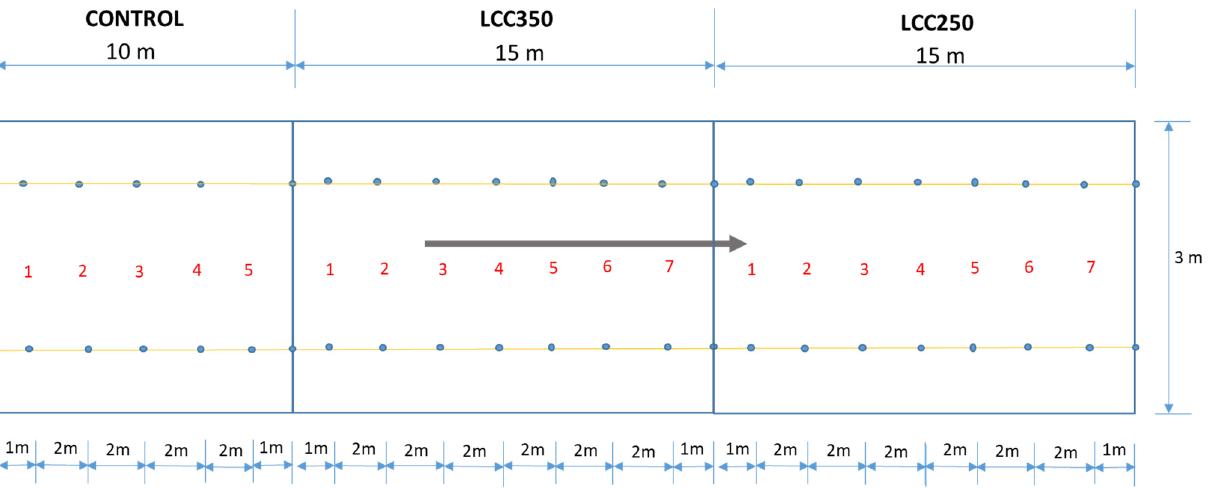
Figure 3. Lightweight de fl ectometer testing layout (Erbsville).